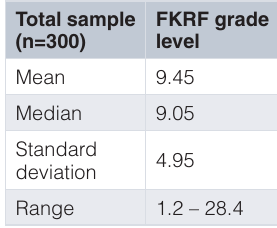
Table 2. Flesch-Kincaid Readability Formula (FKRF) grade level scores for the total